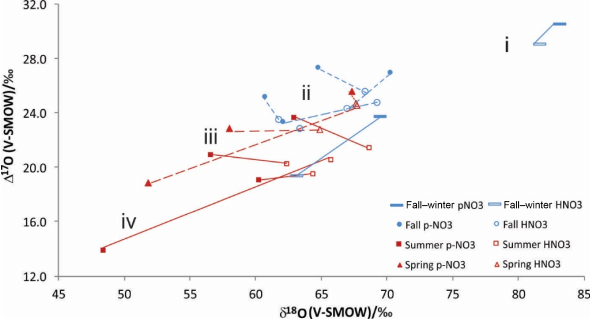
Figure 3. Line-connected δ 18 O and (cid:49) 17 O values for simultane- ously collected HNO 3 (empty symbols) and p NO − from cold (blue) and warm (red) sampling periods.